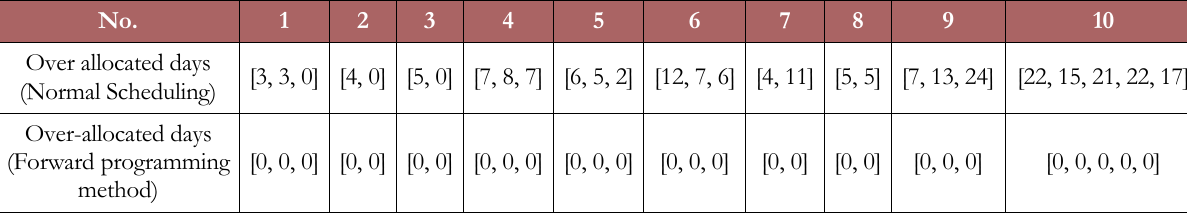
Table 4. Over-allocated days in normal and modified schedules observed before and after using the